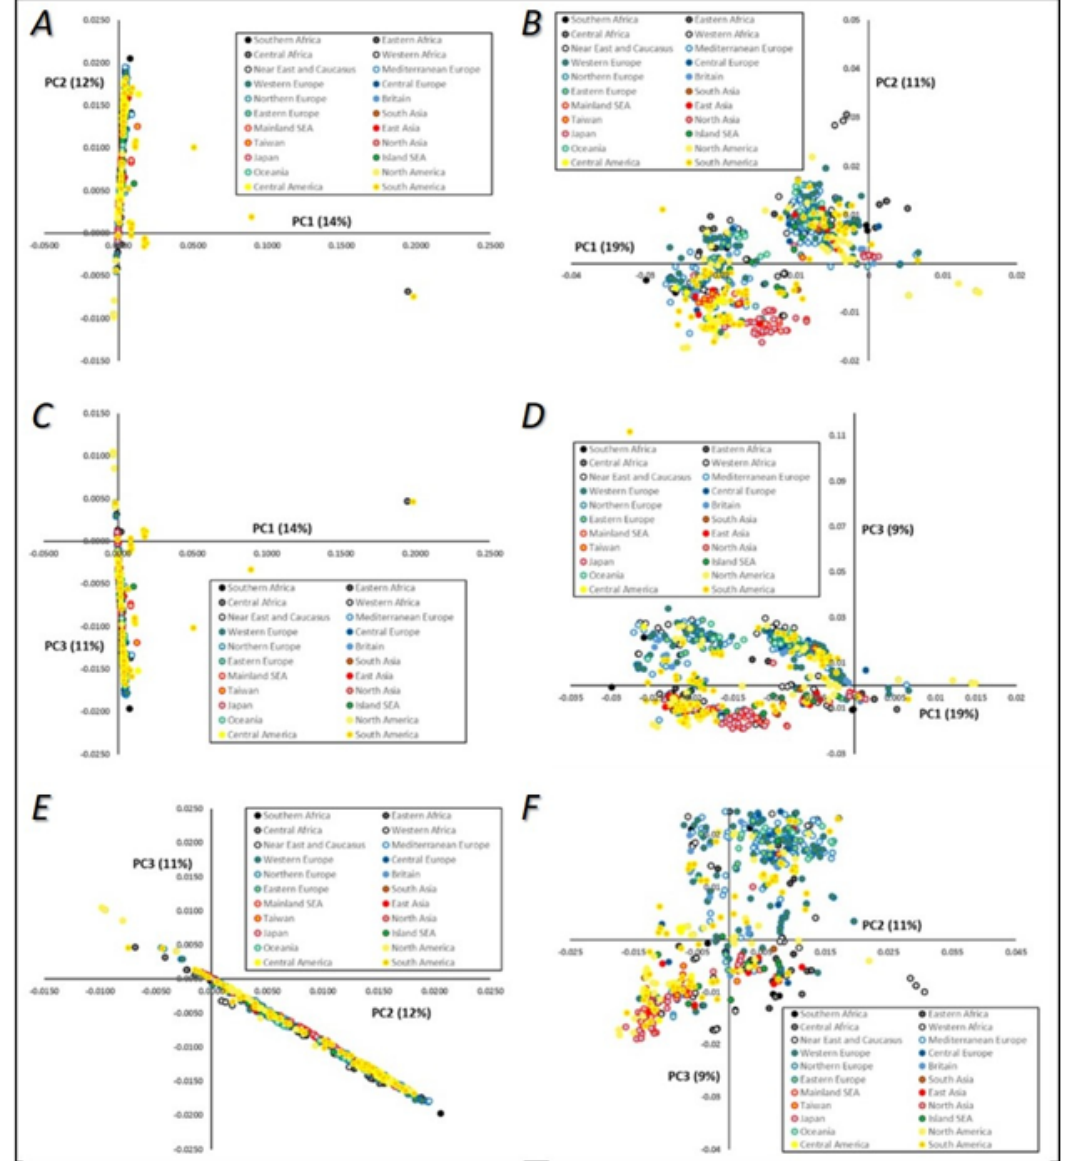
Figure 5. Principal component (PC) analysis visualization of the mtDNA genomes of Saccharomyces cerevisiae . Colors are indicative of strains’ geographical origins. A —PC1 versus PC2; B —PC1 versus PC2, after exclusion of outliers defined in Panel A ; C —PC1 versus PC3; D —PC1 versus PC3, after exclusion of outliers defined in Panel C ; E —PC2 versus PC3; F —PC2 versus PC3, after exclusion of outliers defined in Panel E .